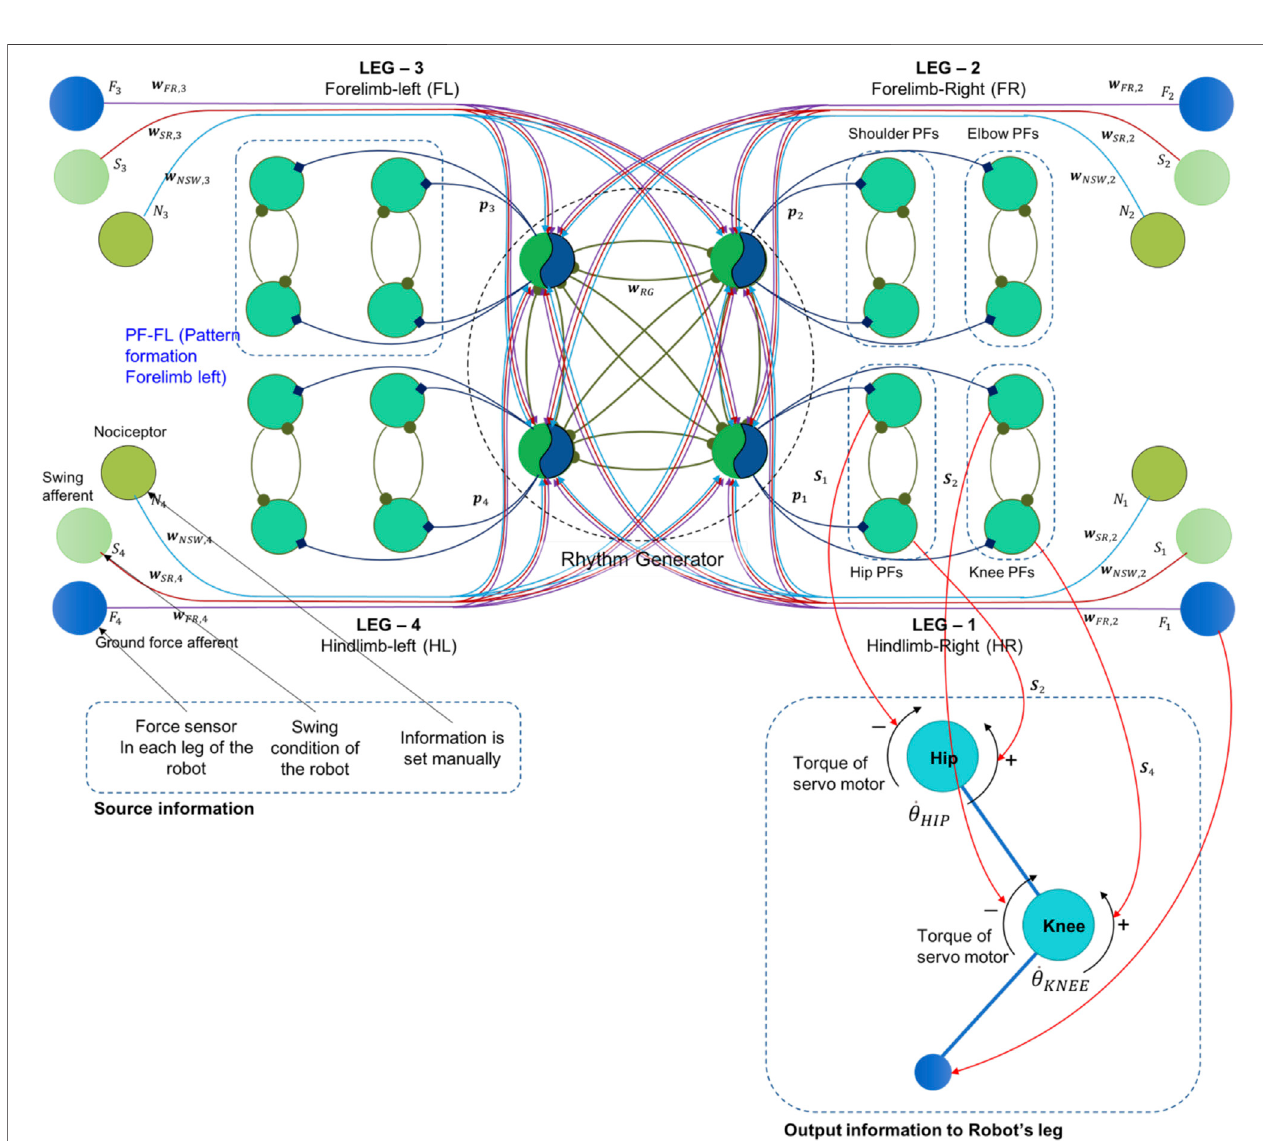
FIGURE 10 | The single-rhythm CPG model with a two-layered CPG. The rhythm generator neurons received feedback signals from a force sensor, a pain receptor, and a swing sensor in each leg.